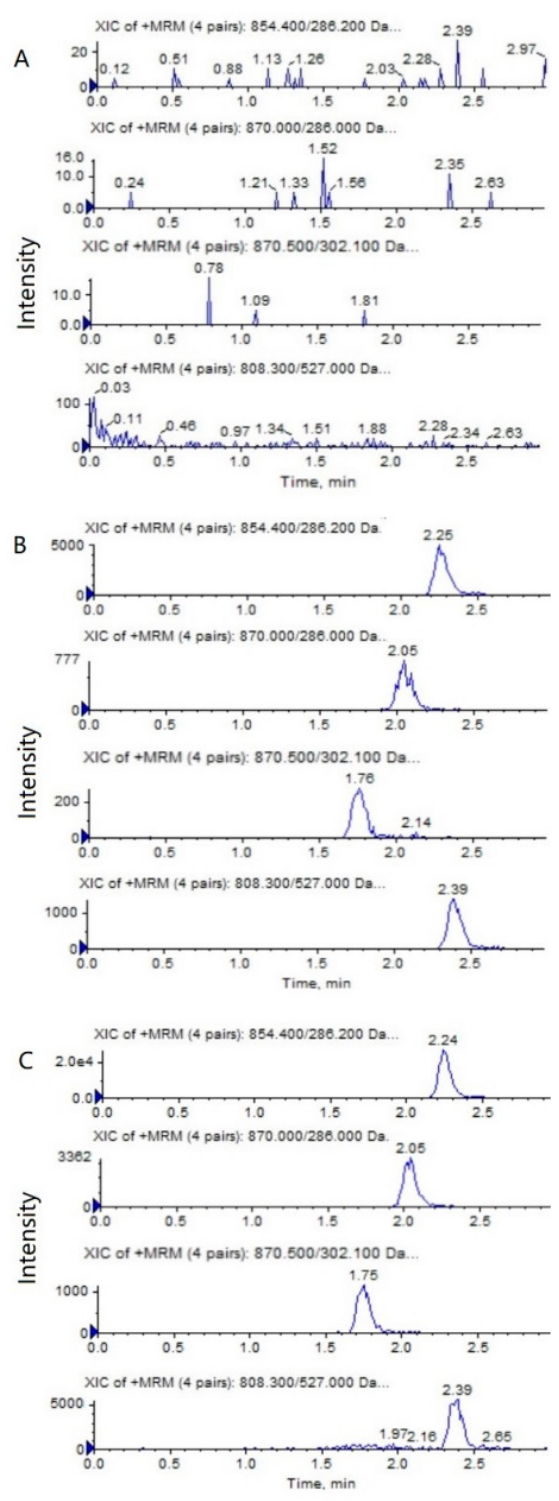
Figure 3. Representative MRM chromatograms of PTX ( m/z 854.4 → 286.2), 6 α‐ OHP ( m/z 870.0 → 286.0), 3 ′‐ OHP ( m/z 870.0 → 302.1), and DTX ( m/z 808.5 → 527.0) in tumor tissue homogenate: